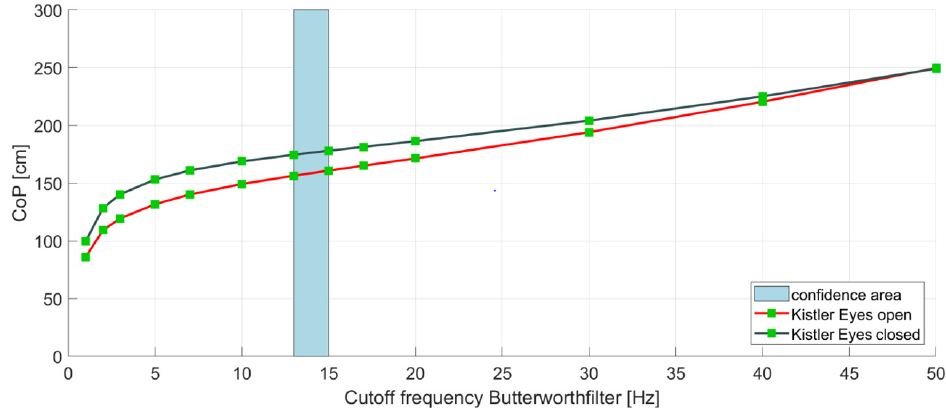
Figure 8. Result of the variation of different filter frequencies in the bipedal state for the measurement conditions of eyes open (red) and eyes closed (black).